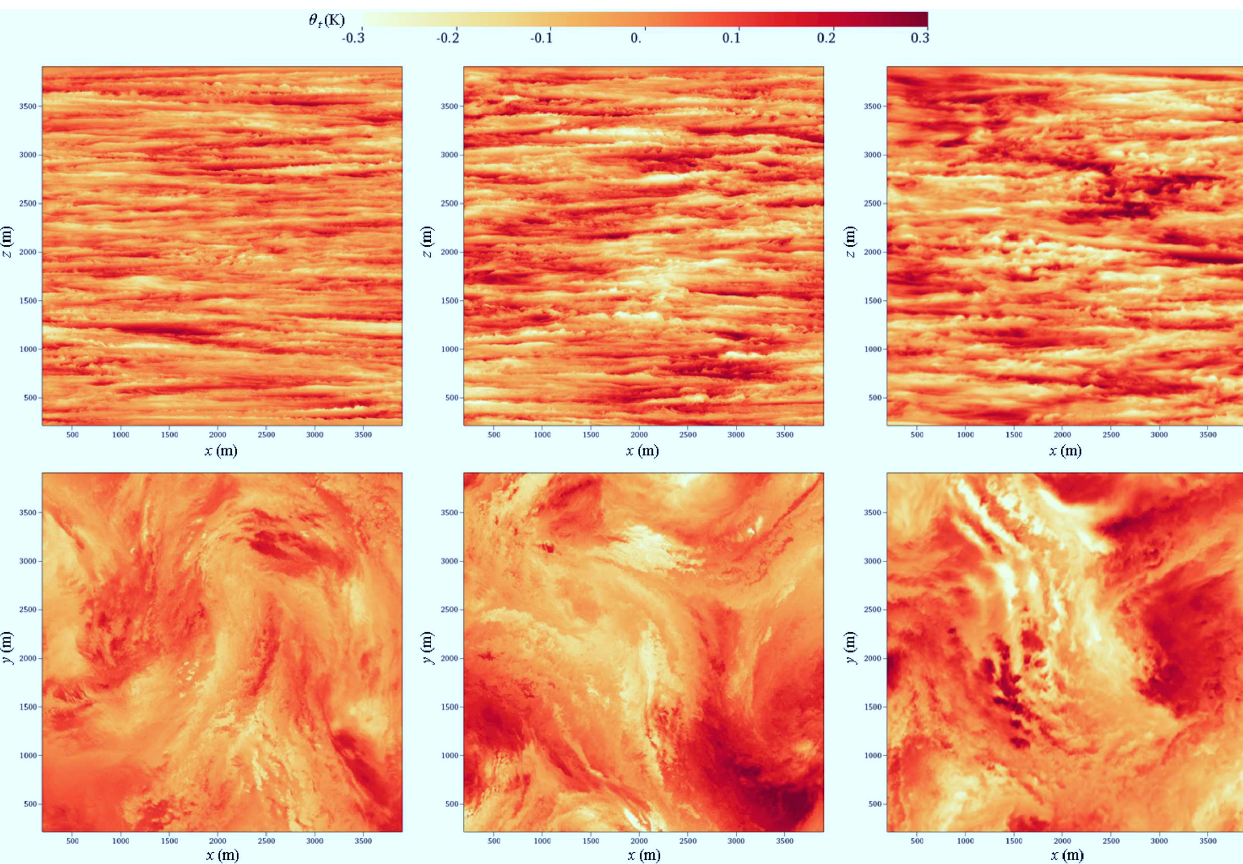
Figure 6. Snapshots of potential temperature fluctuations θ t for the weak forcing case, run S02 (left); moderate forcing case, run M02 (center); and strong forcing case, run S10 (right). The top panels show vertical slides taken at y = L y / 2, while the bottom panels show horizontal slides taken at z = L z /